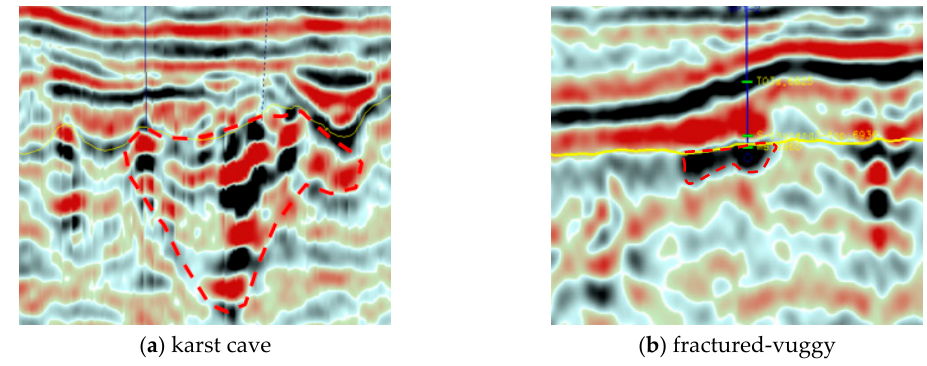
Figure 3. Seismic amplitude of different reservoir bodies in the Tarim Basin: ( a ) strong bead-like reflection for karst caves; ( b ) strong flake-like reflection for fractured-vuggy bodies.